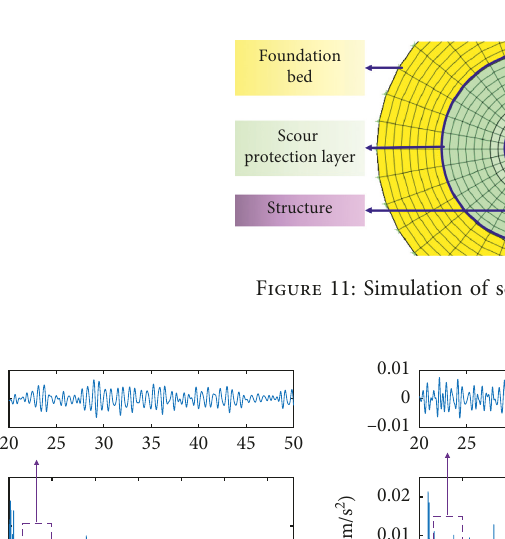
Figure 10: Simulation of infill sand loss in the caisson. (a) Intact. (b) Case DC1. (c) Case DC2. (d) Case DC3.